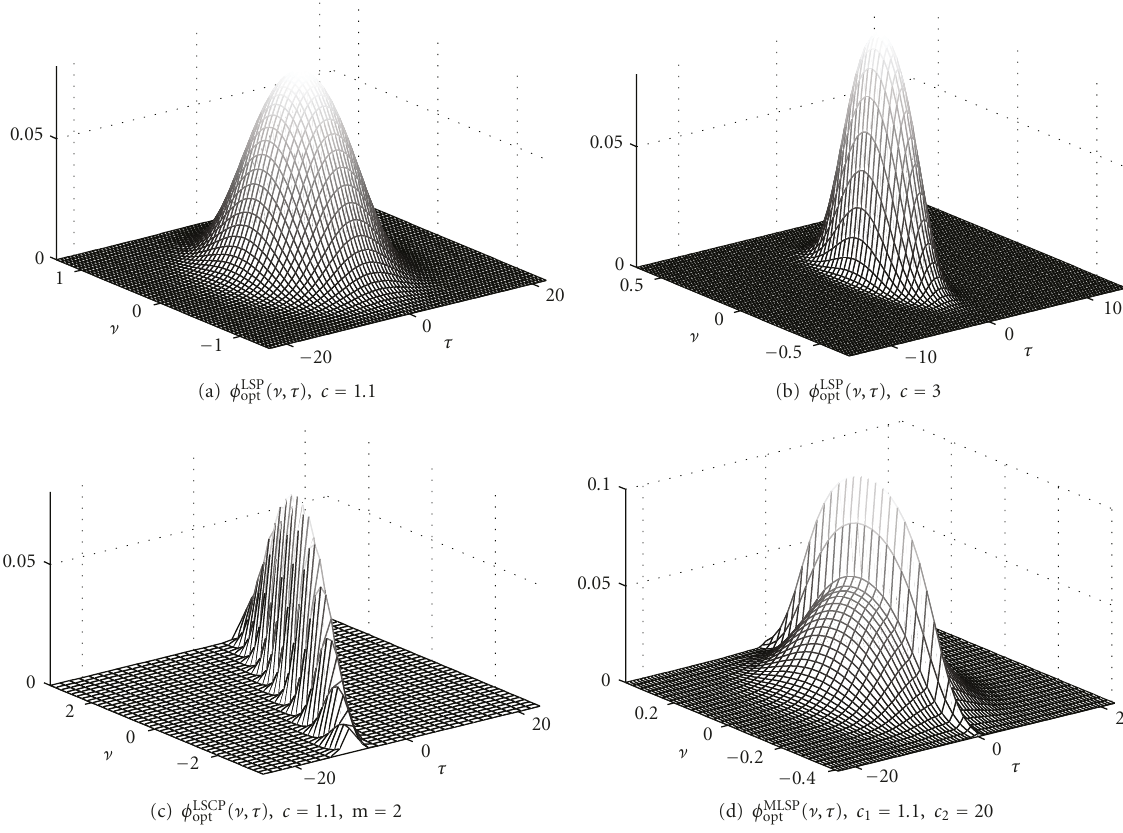
Figure 3: The mean square error optimal ambiguity domain kernel corresponding to processes with covariance functions in Figure 1 for : c = 1 . 1, (b) φ LSP : c = 3, (c) φ LSCP : c = 1 . 1, m = 2, and (d) φ MLSP : c 1 = 1 . 1, c 2 = 20. N = 256 and F s = 7: (a) φ LSP opt opt opt opt Table 2: The mean square error of the LSCP-optimal multitapers and weights (LSCP opt ) compared to optimal choices of parameters of di ff erent methods evaluating the class of LSCPs when c = 1 . 1, 3, and 20, and m = 2, d = − 2. Method c = 1 . 1 c = 3 c =